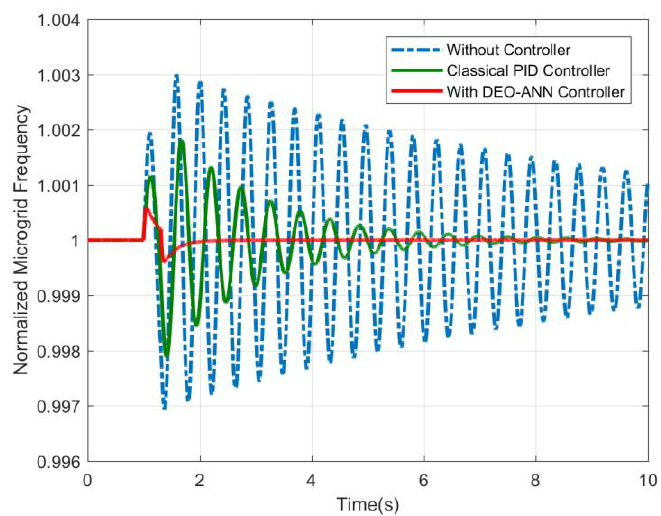
Figure 12. MG system frequency (in p.u).